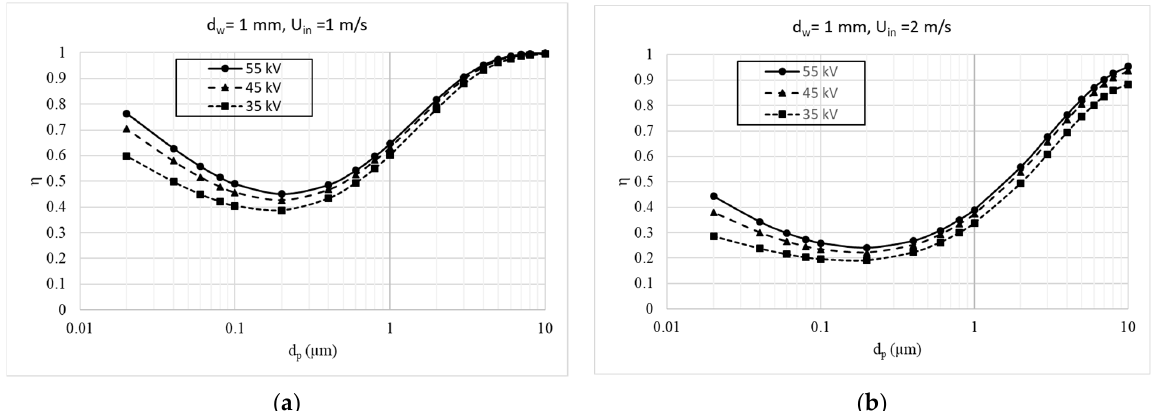
Figure 13. Variation of the ESP collection efficiency with particle diameter for S y = 115 mm, d w = 1 mm, ( a ) U in = 1 m/s, ( b ) U in = 2